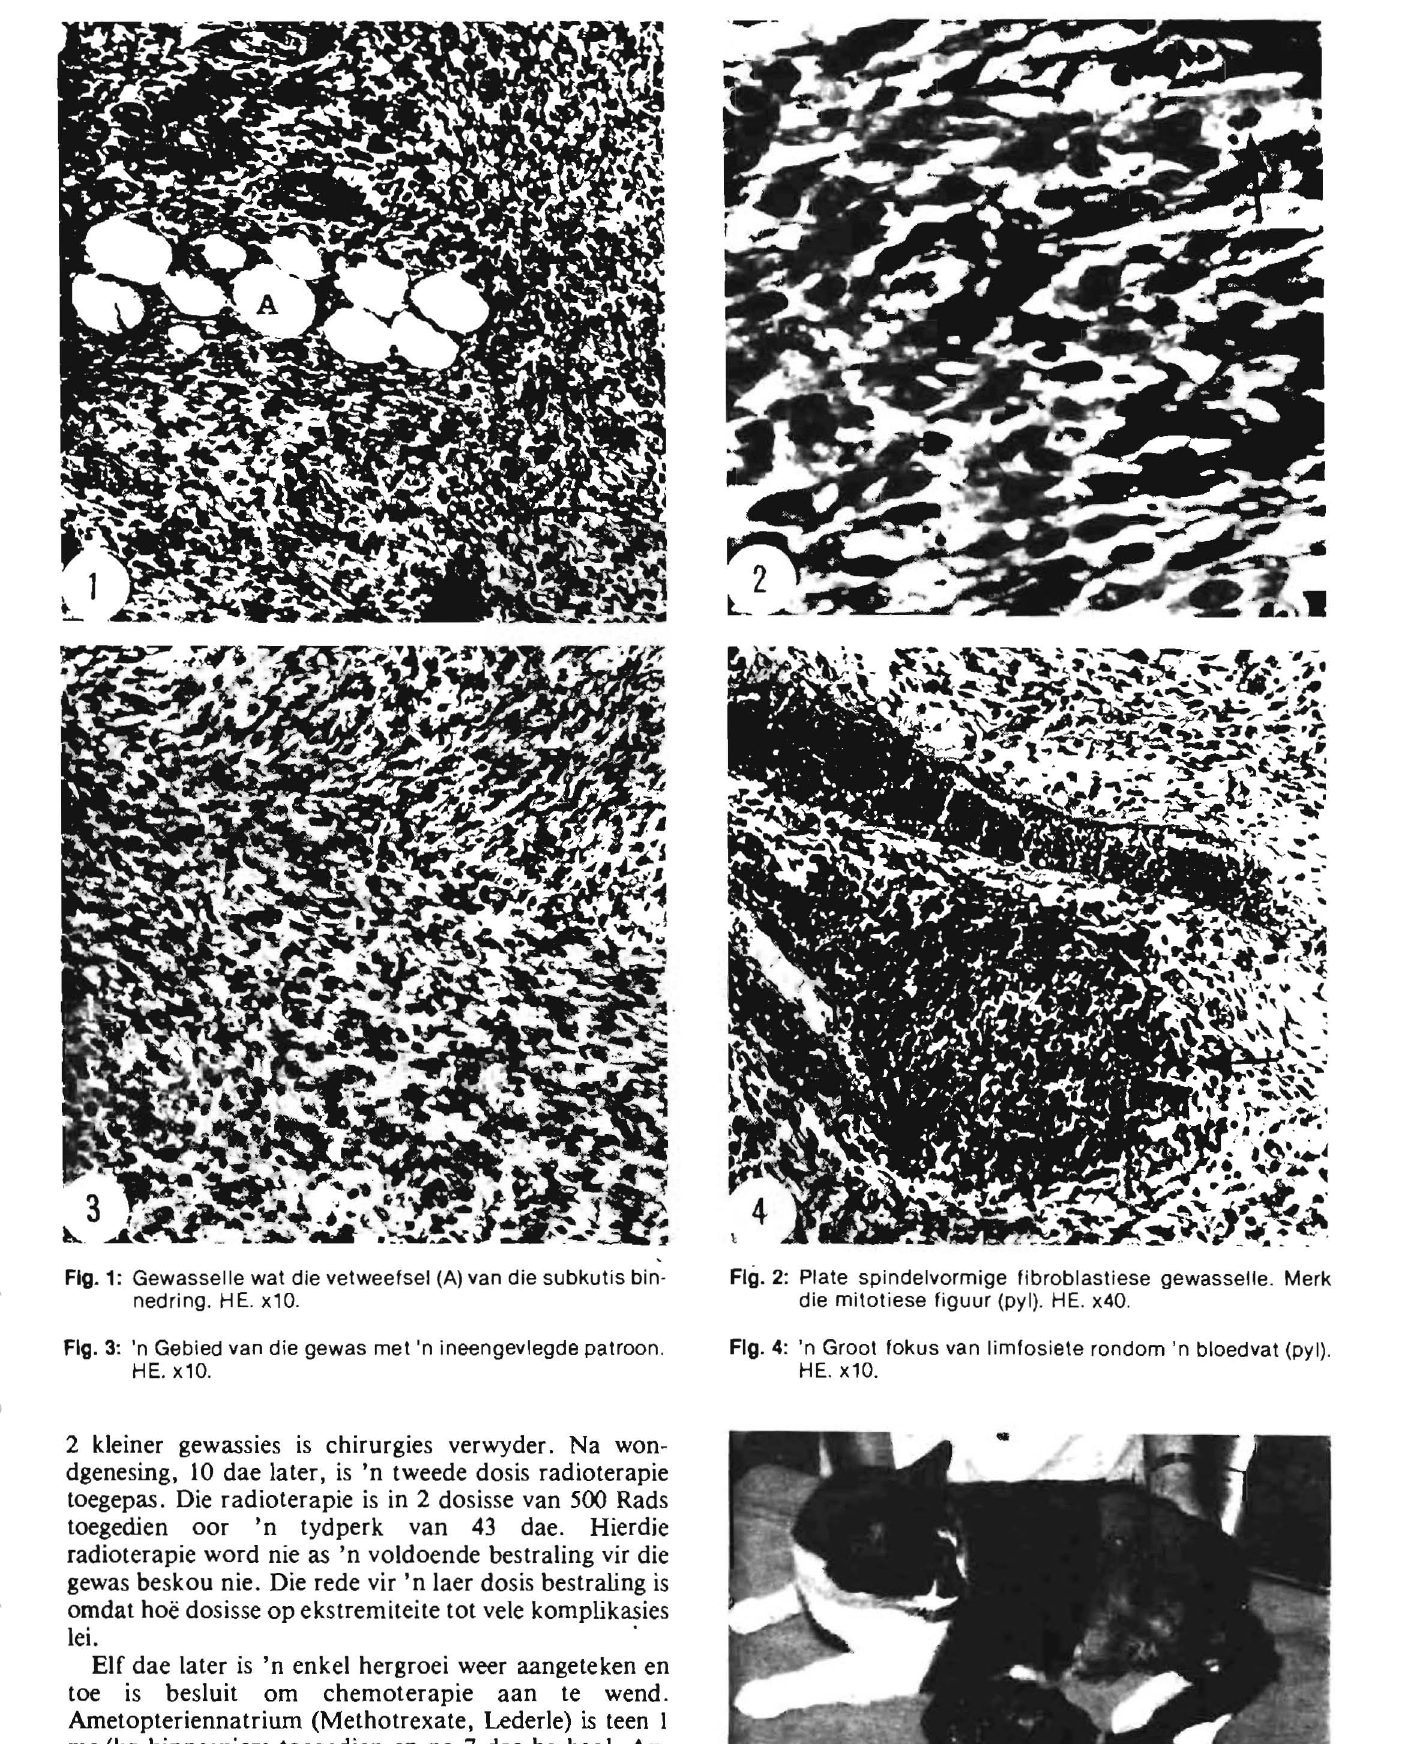
Fig. 5: Flbrosarkoom verwyder vanal linker